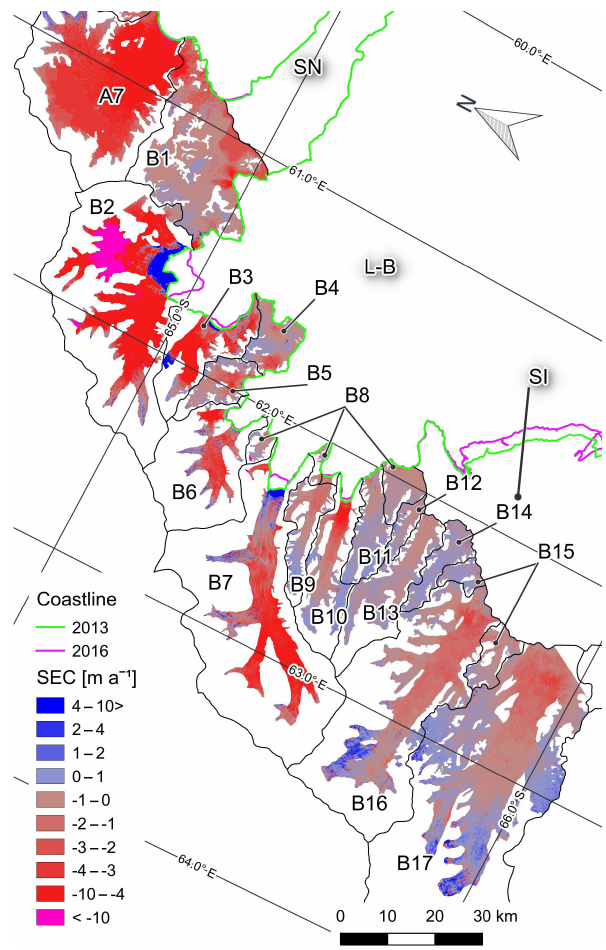
Figure 6. Map of surface elevation change (SEC, ma − 1 ) from May–June 2011 to June–July 2013 on glaciers of the Larsen B em- bayment (L-B). SN – Seal Nunataks. SI – Scar Inlet ice shelf.